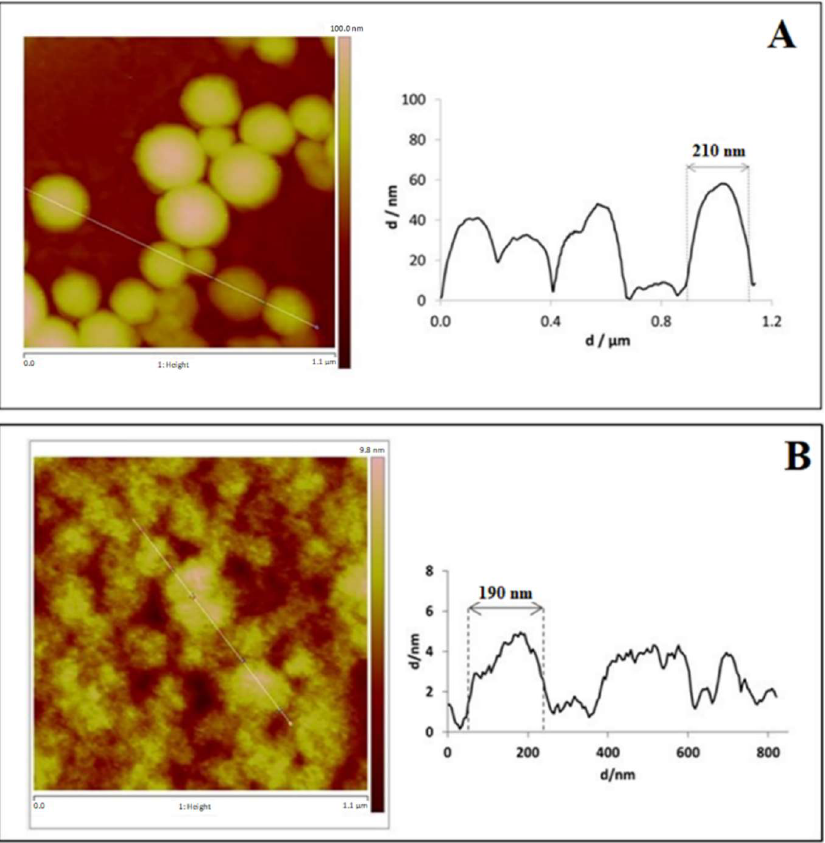
Figure 5. Atomic Force Microscopy (AFM) sectorial analysis of: ( A ) Albumin empty nanoparticles and ( B ) Parvifloron D-loaded nanoparticles. Particle sizes of 210 nm and 190 nm are also represented, for A and B, respectively.